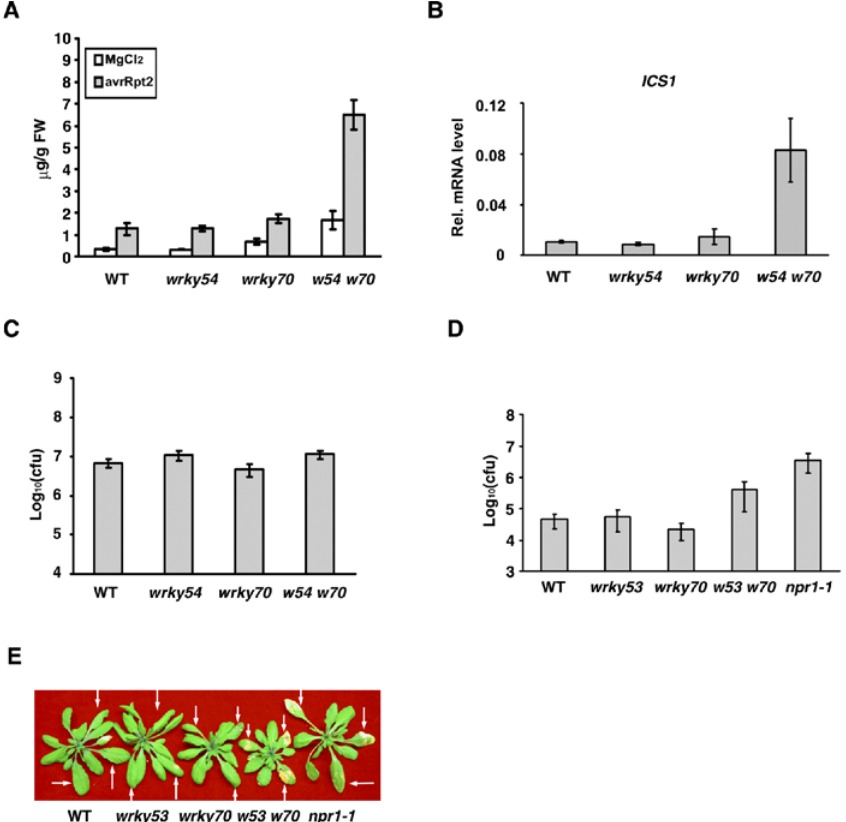
Figure 6. Defects in WRKY70 and WRKY54 Result in SA Overaccumulation (A) Plants were dipped in either a 10 mM MgCl 2 solution or a suspension of Psm ES4326 avrRpt2 to trigger SA production. Free SA was extracted and measured from three samples for each datapoint 3 dpi. Error bars represent SDs. This experiment was repeated twice with similar results. (B) The SA biosynthesis gene ICS1 is upregulated in the wrky54 wrky70 ( w54 w70 ) double mutant. Relative transcript levels were determined by RT-qPCR after normalization to ubiquitin. Error bars represent SD from three PCR runs. (C) Lack of resistance in w54 w70 , measured by bacterial growth 3 dpi with a high dose of Psm ES4326. (D and E) The wrky53 wrky70 ( w53 w70 ) double mutant displays an EDS phenotype. Bacterial growth was measured in 3 dpi (D) and disease symptoms were recorded in 3 dpi (E). Both (C) and (D) were done three times each with similar